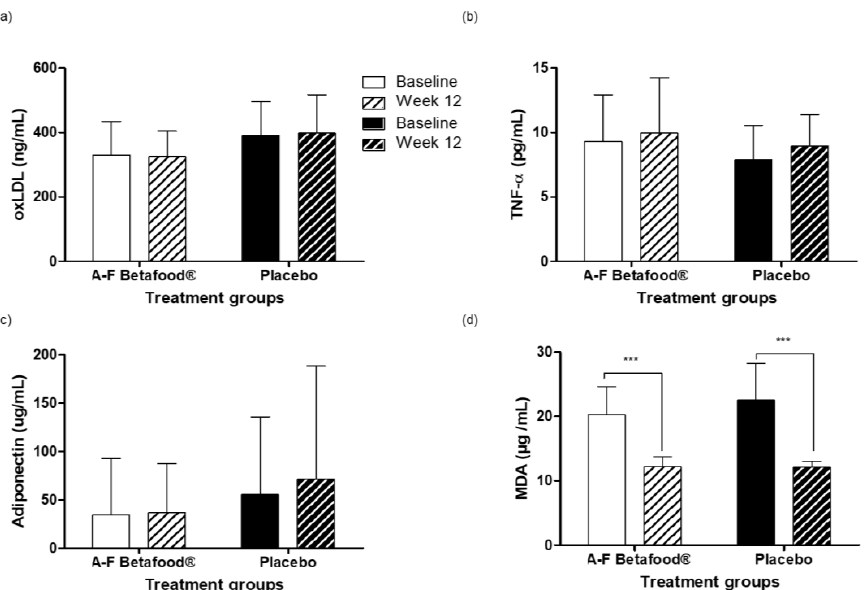
Figure 6. Oxidative stress, inflammatory, and gallbladder health markers in the per protocol population at baseline and week 12 post-supplementation with A-F Betafood ® or placebo ( n = 42). ( a ) oxLDL, ( b ) TNF- α , ( c ) adiponectin and ( d ) MDA. Mean ± SD, where *** p < 0.001. TNF- α , tumor-necrosis factor— α ; MDA, Malonyldialdehyde; oxLDL, oxidized low-density lipoprotein. 3.3.2. Total Cholesterol, LDL-C, HDL-C, Triglycerides There were no significant differences within or between the A-F Betafood ® and placebo groups in the total cholesterol, LDL-C, HDL-C, or triglycerides concentrations from baseline to week 12 (Figure 7).